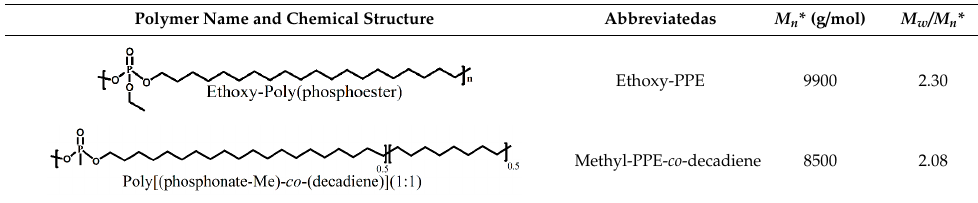
Table 1. List of the polymers under investigation with their chemical structure, short naming, and number average molar mass M n . Polymer Name and Chemical Structure